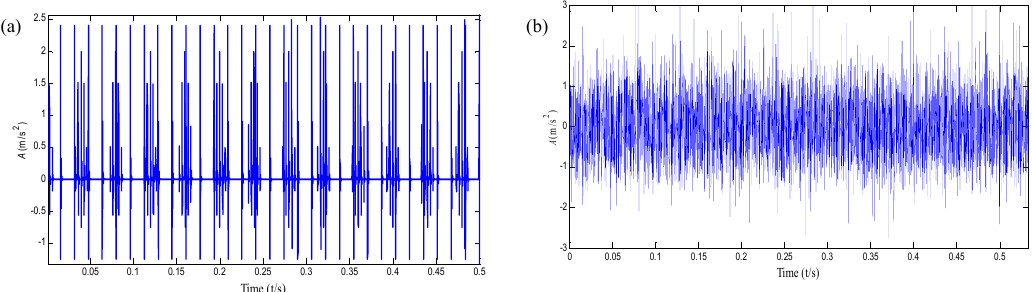
Figure 7. The time-domain waveform of the compound fault simulation signal: ( a ) Outer race and inner race fault; ( b ) compound signal with gauss noise.